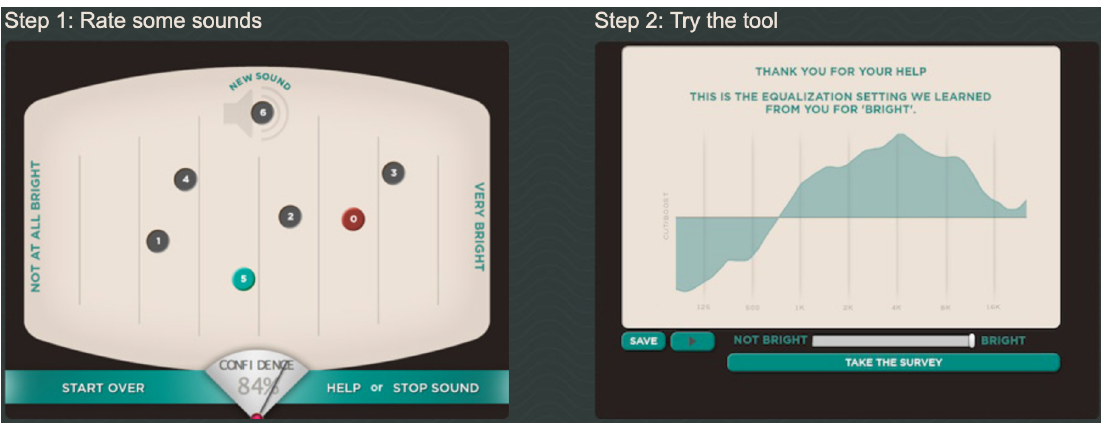
Figure 3. SocialEQ: an evaluative interface for controlling an equalizer. ( left ) The evaluation panel. Here, the user rates options to teach the machine a concept. ( right ) Once the machine has learned a concept (“bright”, in this case), a single-slider control is provided to let the user fine-tune the equalization in terms of that concept. Screen capture created by the